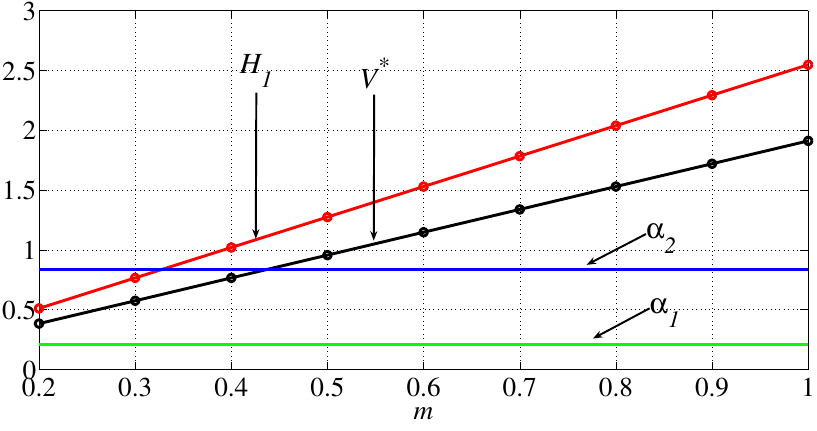
Figure 2. Switching angles, dc voltage source and fundamental harmonic behaviors as a function of m for a single-phase 5-level